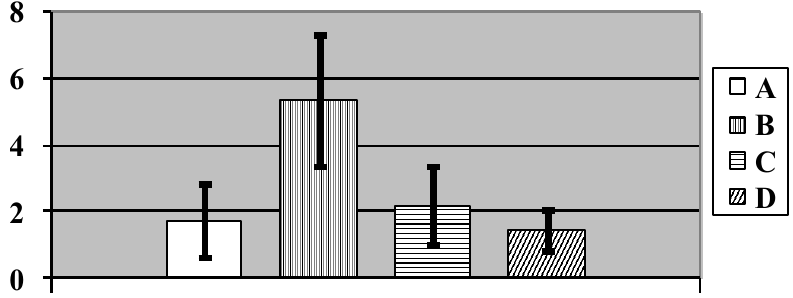
Figure 5. Number of brown pigment micro aggregates per square of Avtandilov’s grid in the spleen’s red pulp of rats exposed (A) to water (Control); (B) to water suspension of copper oxide nanoparticles; (C) to the same against the background of BPC administrations; and (D) to the BPC only. (Average values with 95% CI). Differences are statistically significant between (B) or (C) vs. (A), and between (C) vs. (B) ( p < 0.05 by Student’s t -test).